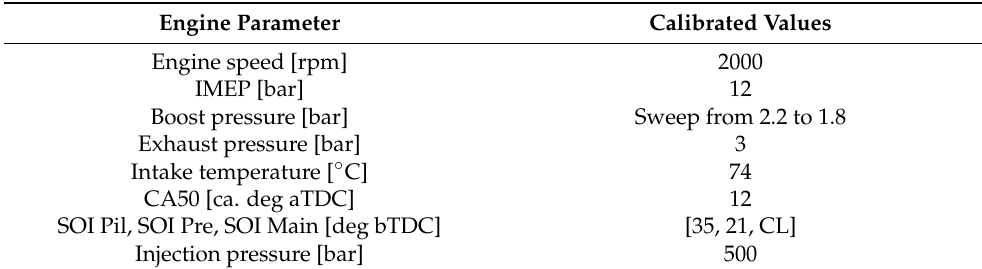
Table 3. Engine operating conditions during boost pressure sweep.